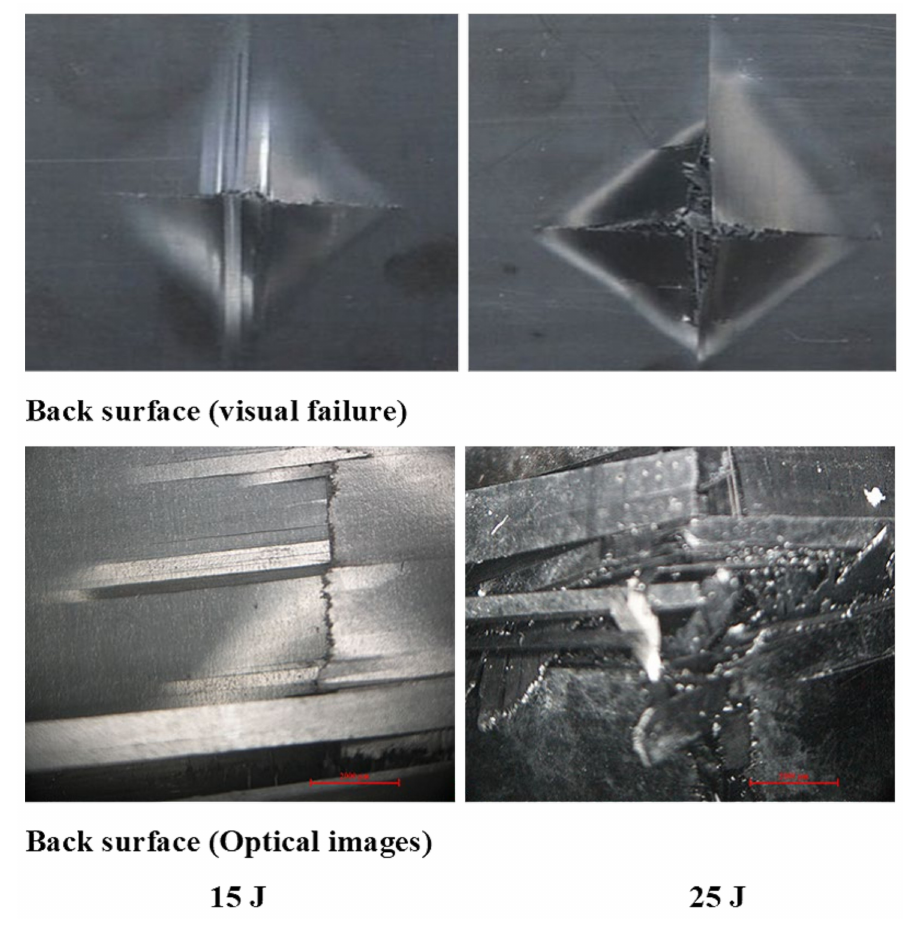
Figure 21. Pictures of the back surface failure view with visual and optical microscopy of [A/B] at 15 and 25 J. Table 3. Measurements of the fail areas for the composite